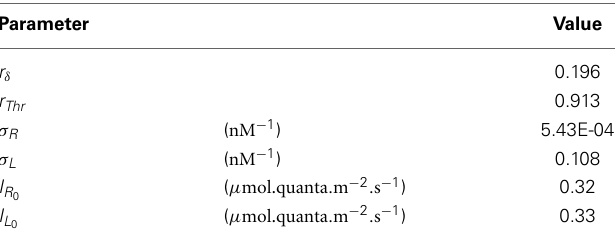
Table 2 | Best-fitting parameter set for the light input pathway. Parameter